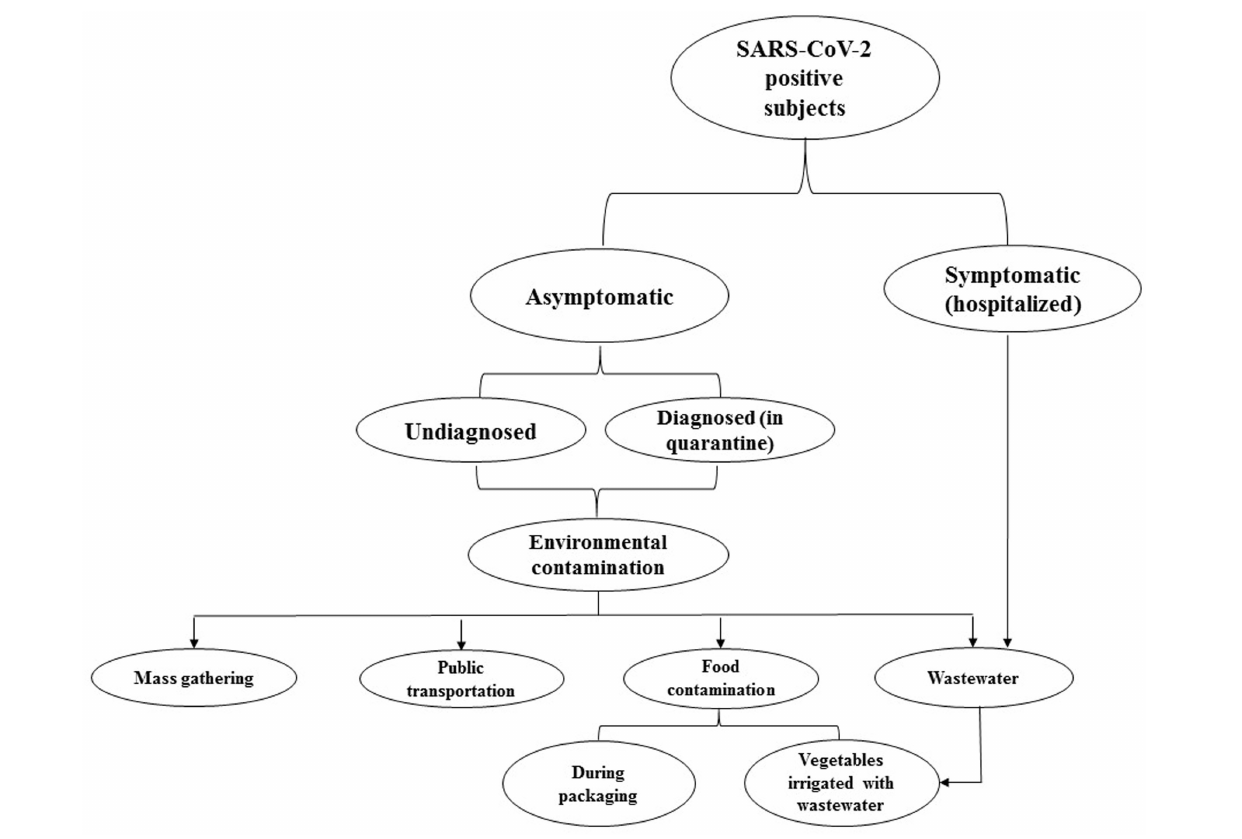
FIGURE 1 | This flowchart represents the probable environmental distribution of COVID-19. Accordingly, asymptomatic subjects, particularly those who are undiagnosed, can disperse infective virus particles. Discharging the virus from stool may increase the load of SARS-CoV-2 in wastewater. Therefore, concerning the insufficiency of current wastewater treatment systems in eliminating the virus, wastewater can lead to the further distribution of SARS-CoV-2 in the environment.